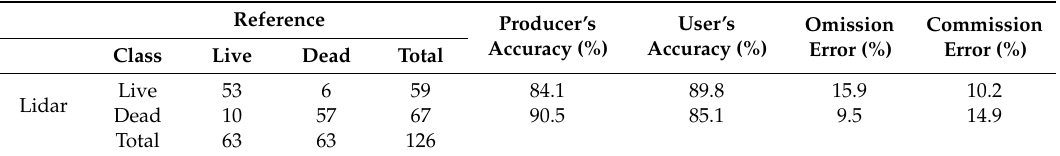
Table 3. Confusion matrices of two random forest classifications using lidar classifiers only (upper) or combined with multispectral imagery classifiers (lower).